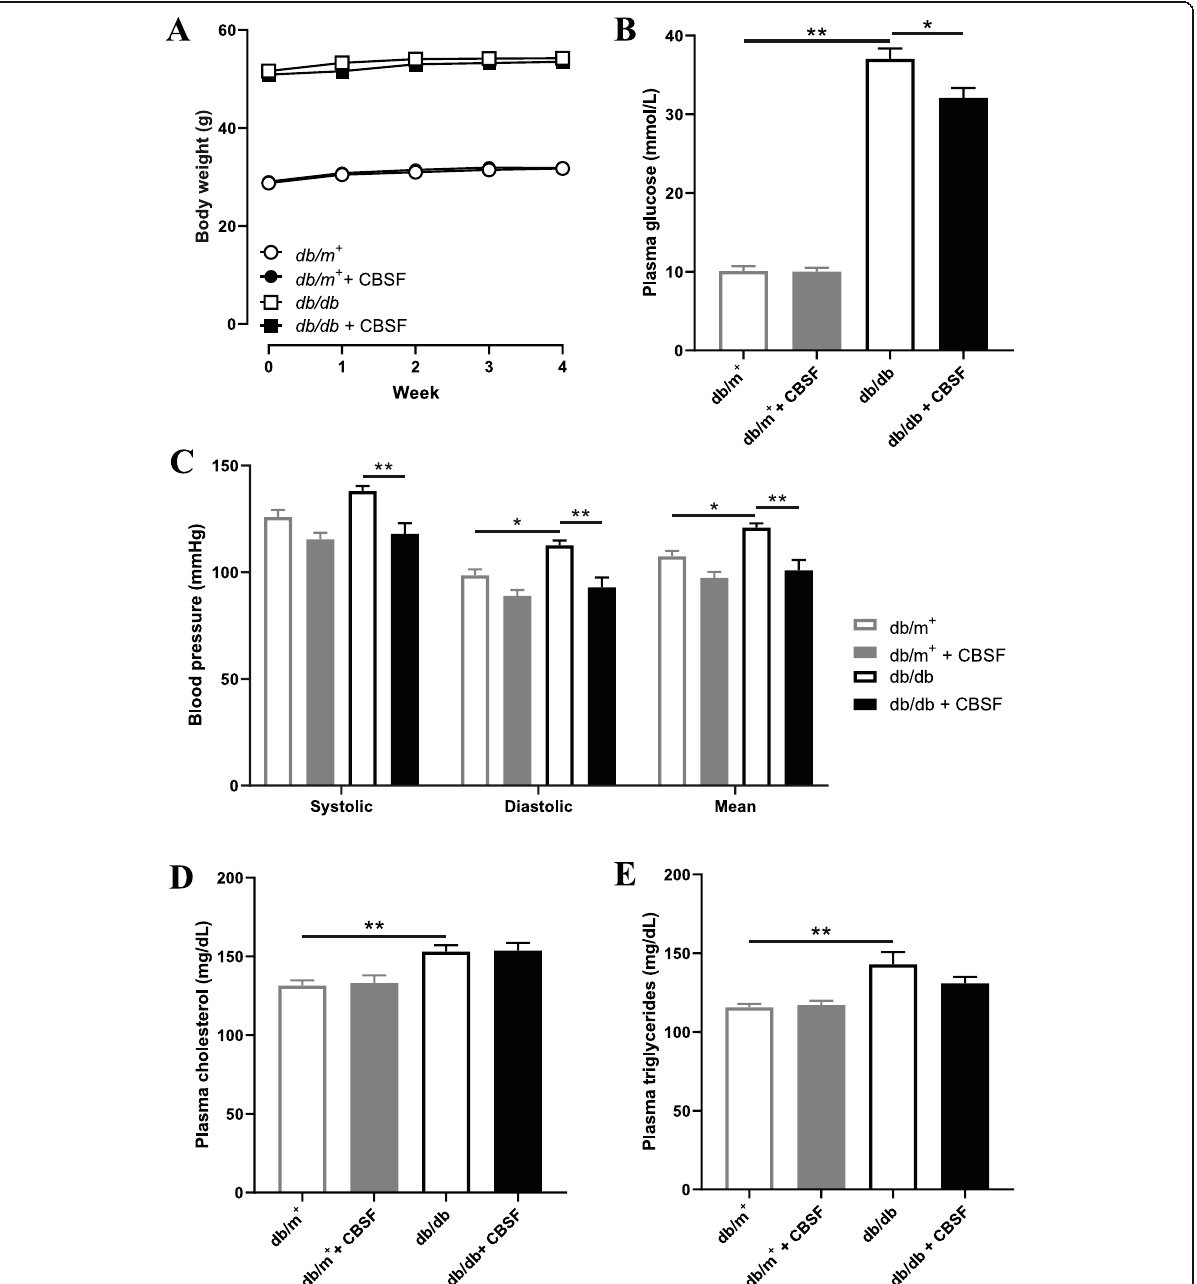
Fig. 1 Effects of oral CBSF treatment on the basic parameters of db/m + and db/db mice. Body weight ( a ), plasma glucose level ( b ), systolic blood pressure, diastolic blood pressure, mean arterial pressure ( c ), plasma cholesterol ( d ) and plasma triglycerides ( e ) of db/m + and db/db mice treated or non-treated with CBSF (25 mg/kg/day) via oral gavage for 4 weeks. Data are presented in mean ± SEM; n = 8, * p < 0.05 and ** p < 0.01. CBSF, crocodile blood soluble